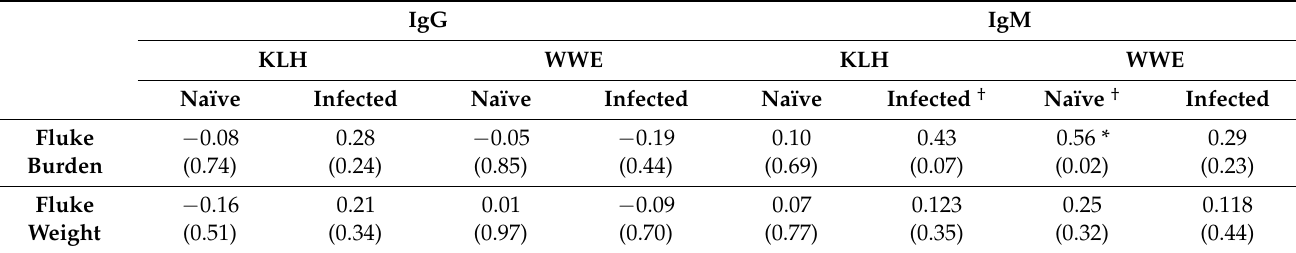
Table 2. Pearson’s correlation coefficients ( p -values in parentheses) for the bovine IgG and IgM humoral responses and the liver fluke burdens and wet weights for experimentally infected animals in study A, B and C ( n = 19). The natural antibody response is assessed to KLH and the